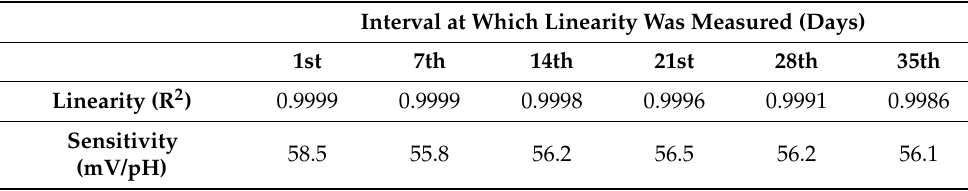
Table 4. Linearity and sensitivity recorded over a period of 35